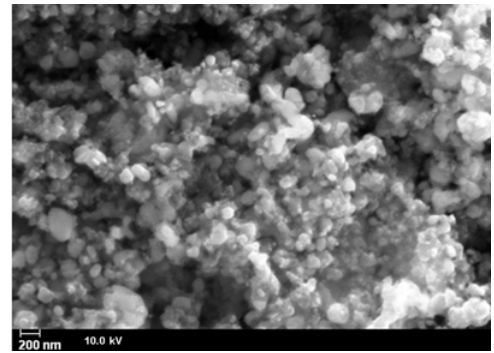
Figure 6. Morphology and size details at higher magnification.